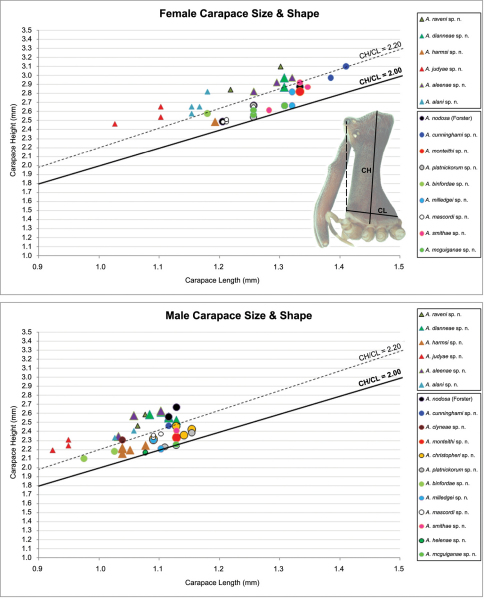
Graphs depicting the relationship between carapace length (CL) and carapace height (CH) for species of Austrarchaea from mid-eastern Australia. Overall body size variation is quantified by the relative lengths of the carapace, whereas carapace shape variation is reflected by the CH/CL ratio; taxa with a very tall, greatly elevated pars cephalica have a CH/CL ratio > 2.20. Circles ● denote New South Wales and southern Queensland species; and triangles ▲ denote Queensland species (from north of the Border Ranges). Note the relatively small body sizes of A. judyae sp. n., A. binfordae sp. n. and A. alani sp. n., and the relatively tall carapaces of most Queensland taxa. Note also the smaller body sizes and lower variance in carapace length among males relative to females.